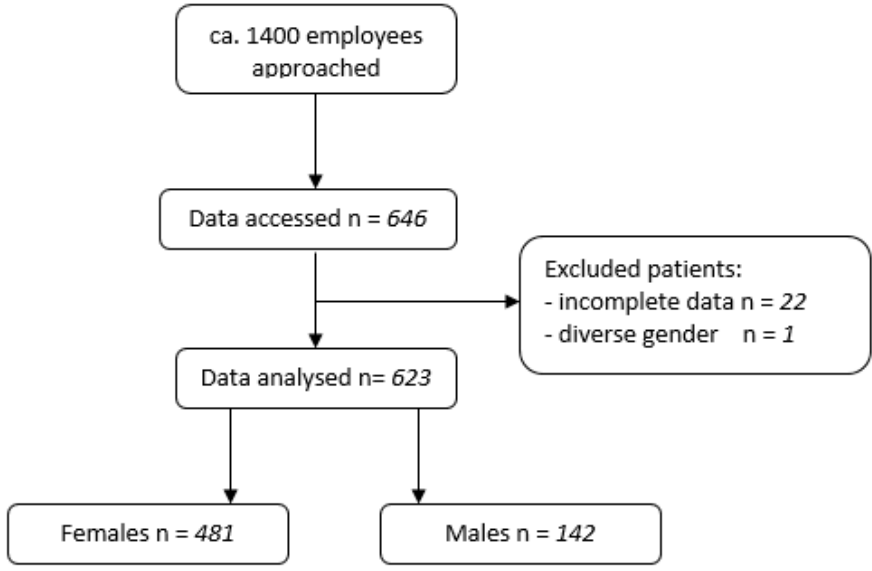
Figure 1. Flowchart of included patients.